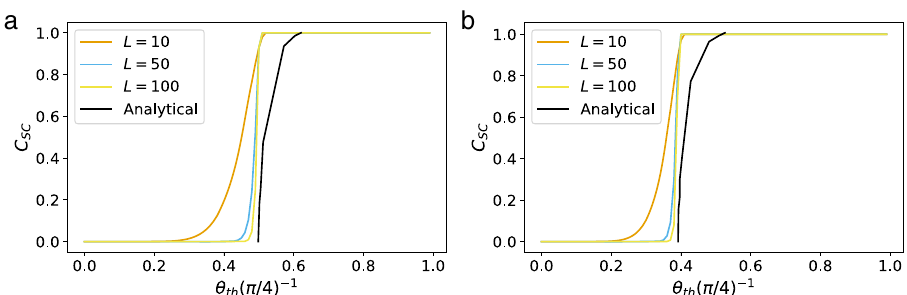
Fig. 4 The sponge-crossing concurrence for the Bethe lattice under the parallel approximation. Results are shown for coordination numbers ( a ) k = 3 and ( b ) k = 4. As the number of layers, L , in the network become larger the numerical values of θ th approaches the analytical value. The solid black lines represent the true concurrence values for the Bethe lattice 24 .